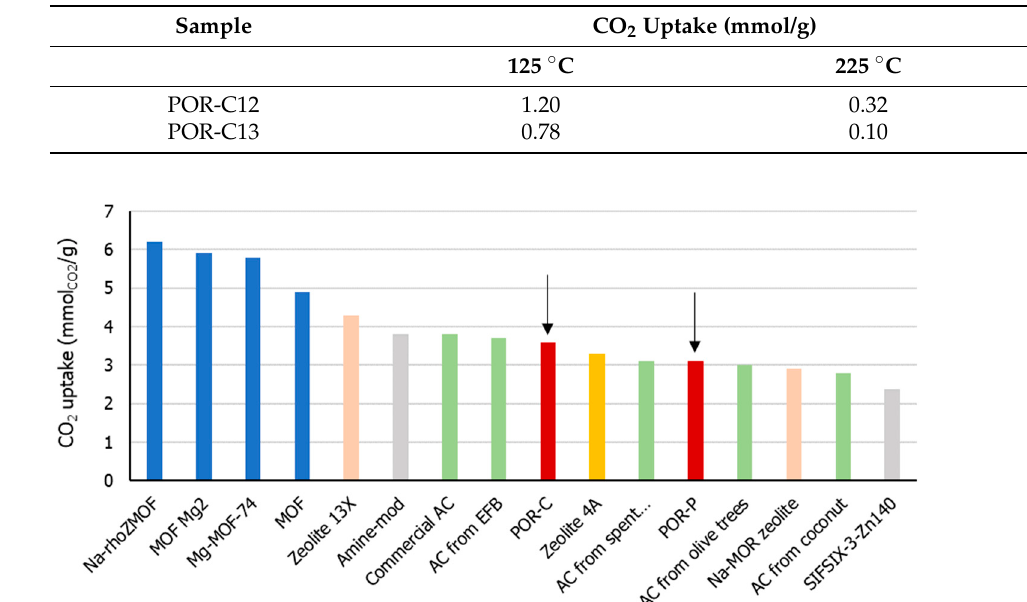
Table 5. CO 2 uptake results of the samples tested at 125 °C and 225 °C.